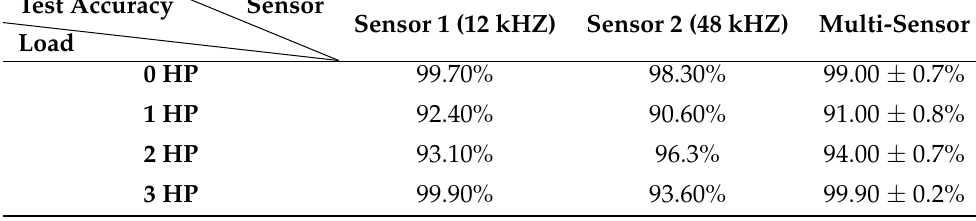
Table 3. Test results of the DWT-LSTM algorithm based on a single sensor and multi-sensor. LoadTest Accuracy